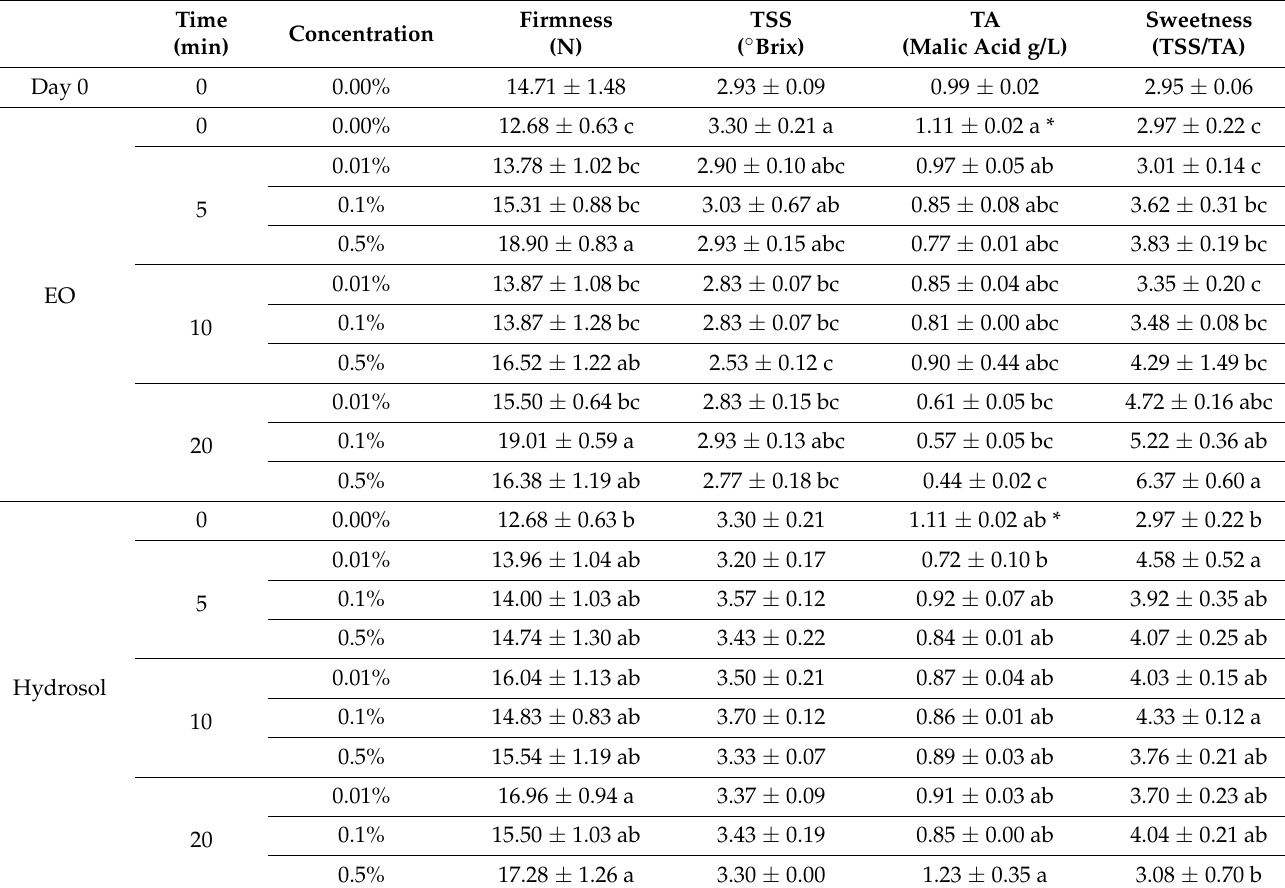
Table 2. Screening of O. dubium EO and hydrosol application effects on fresh cucumber firmness, total soluble solids (TSS), titratable acidity (TA) and sweetness when stored at 11 ◦ C for 9 days. Values presented as mean ± standard error of four biological replicates per treatment. Measurements for day 0 refer to the control. In each column and for each treatment (EO and hydrosol), significant differences ( p < 0.05) are indicated with different Latin letters. For control (0.00%), the asterisk